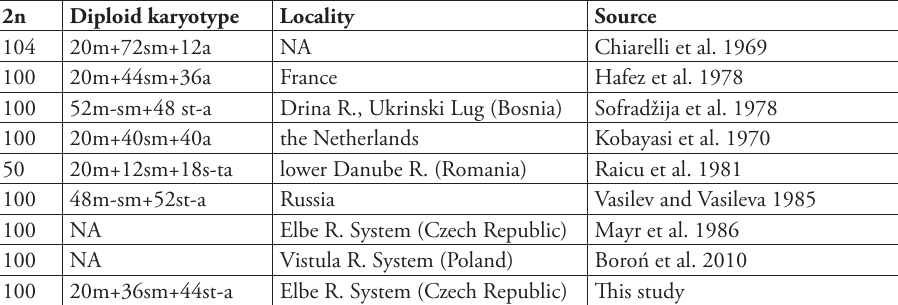
Table 1. Chromosome numbers and karyotypes of Carassius carassius reported from Europe; NA= not